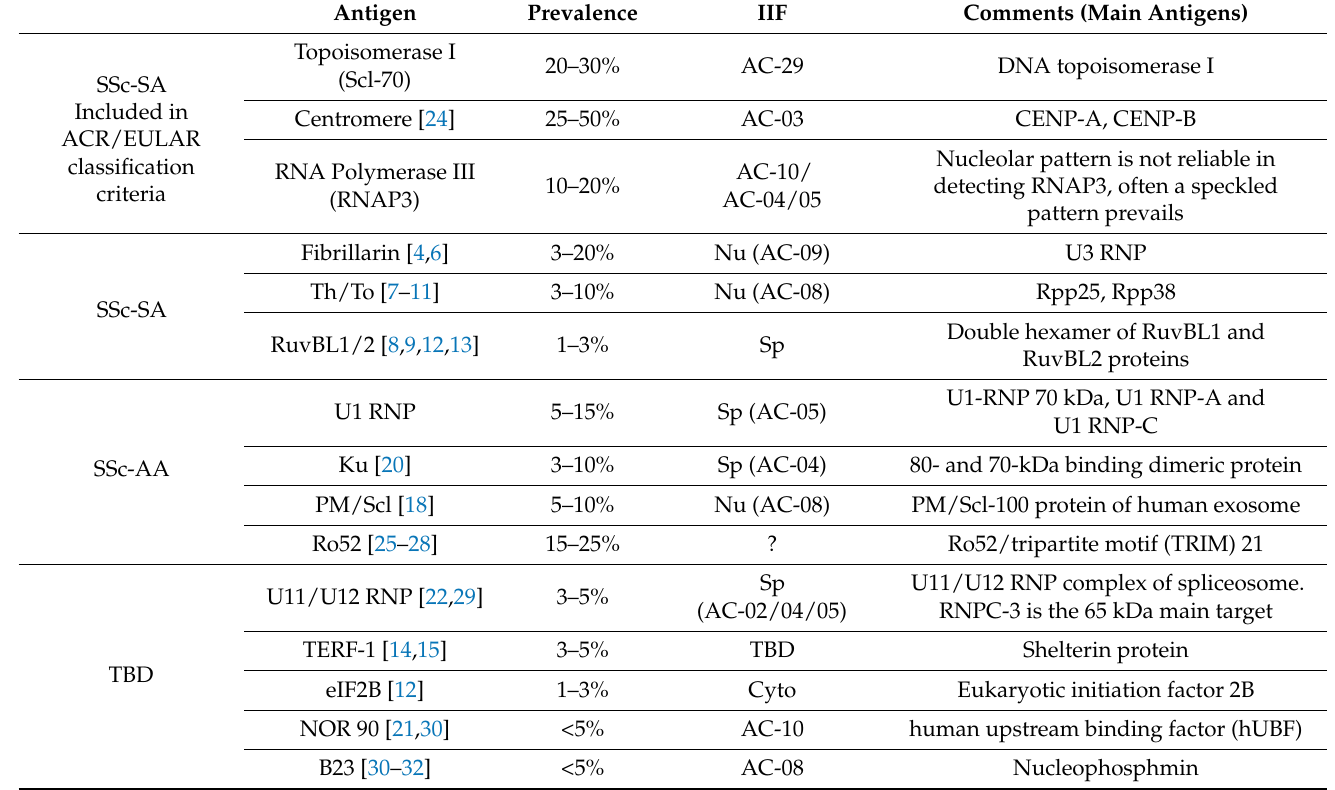
Table 1. Overview of autoantibodies in systemic